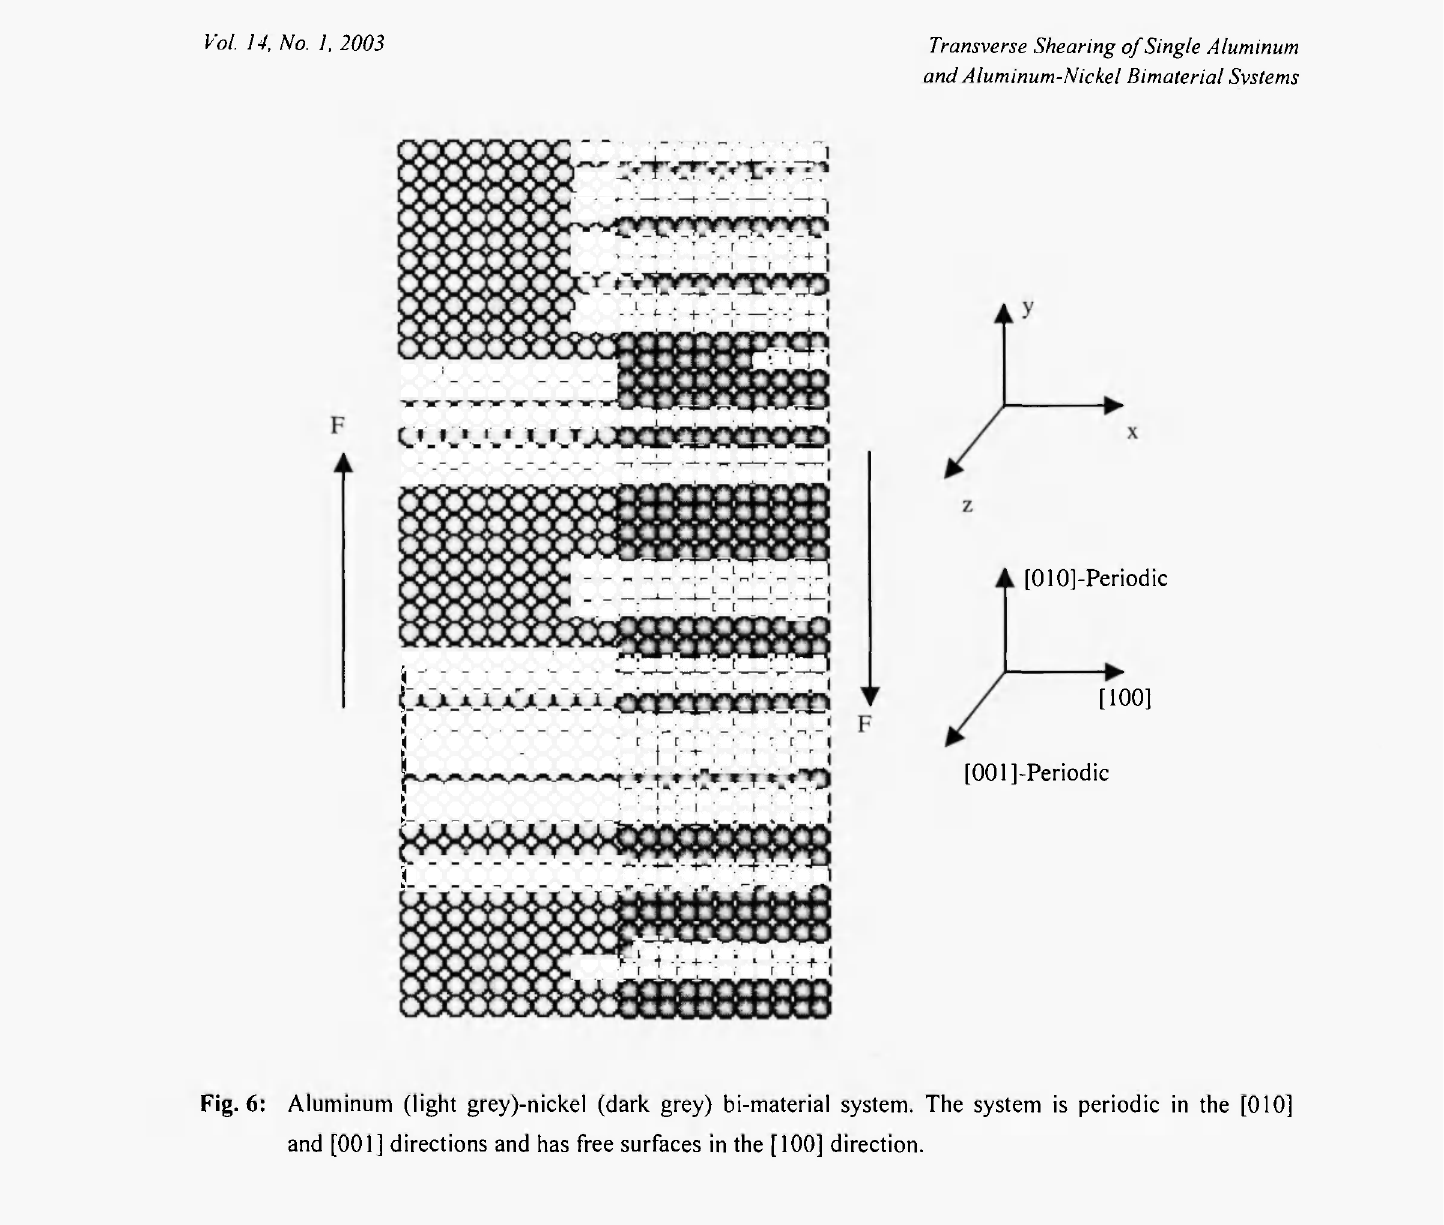
Fig. 6: Aluminum (light grey)-nickel (dark grey) bi-material system. The system is periodic in the [010] and [001] directions and has free surfaces in the [100]